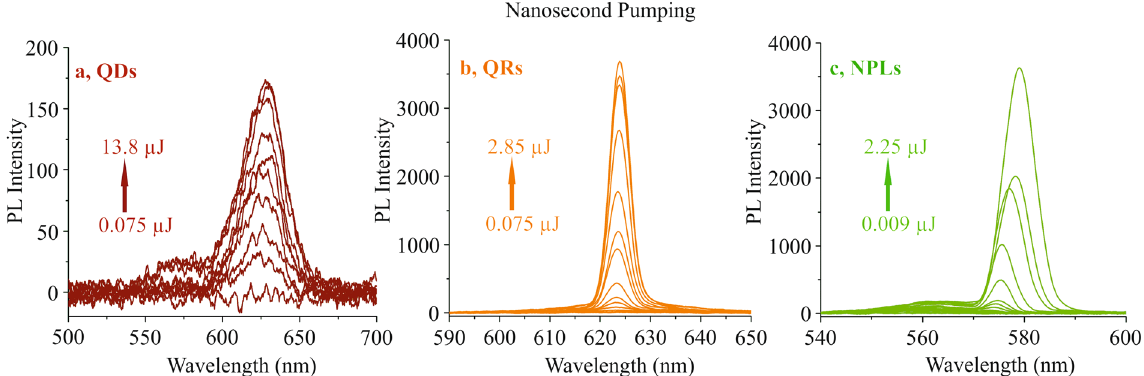
Figure 4. The comparison between nanosecond pumping of ( a ) QDs, ( b ) QRs and ( c ) NPLs. The arrows in each graph (red for QDs, orange for QRs and green for NPLs) represents the energy range, adopted for each case. The QRs and NPLs show clear indication of ASE at the peak wavelengths of 624 nm and 579 nm, respectively but only fluorescence is detected from QDs at the peak wavelength of 628 nm.